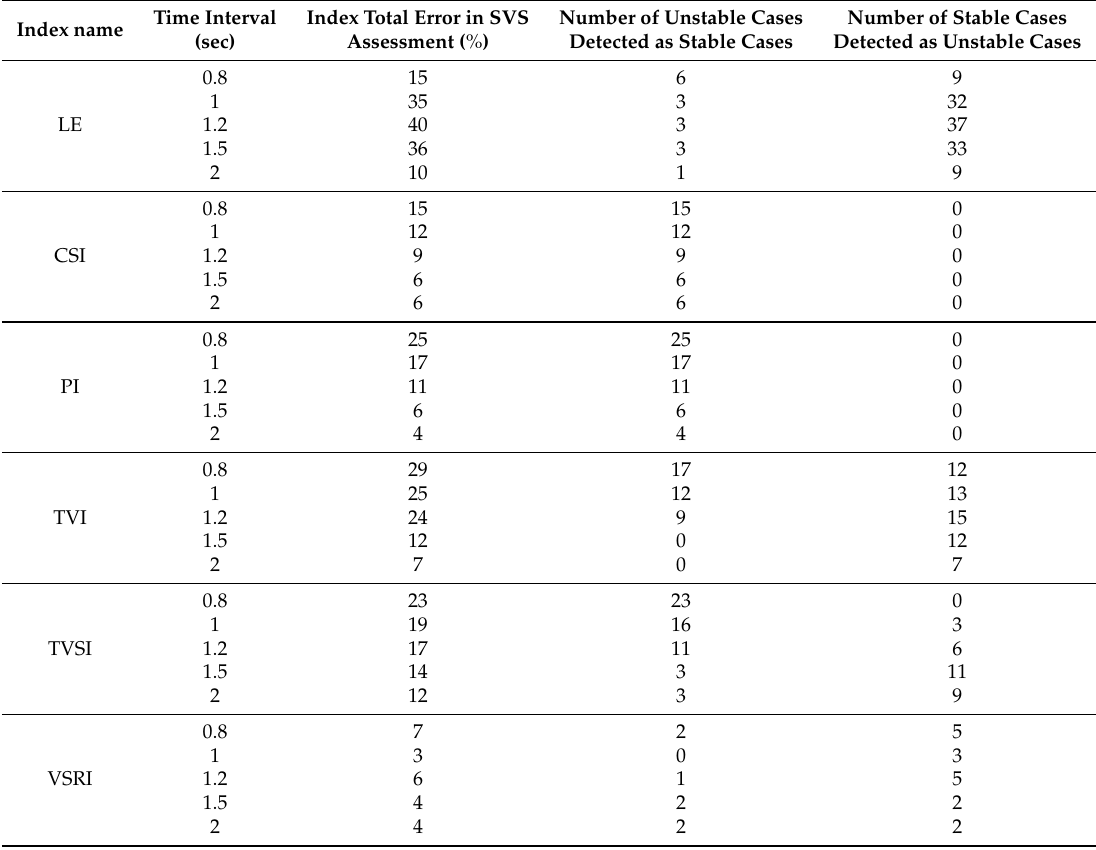
Table 2. SVS indices performance in instability